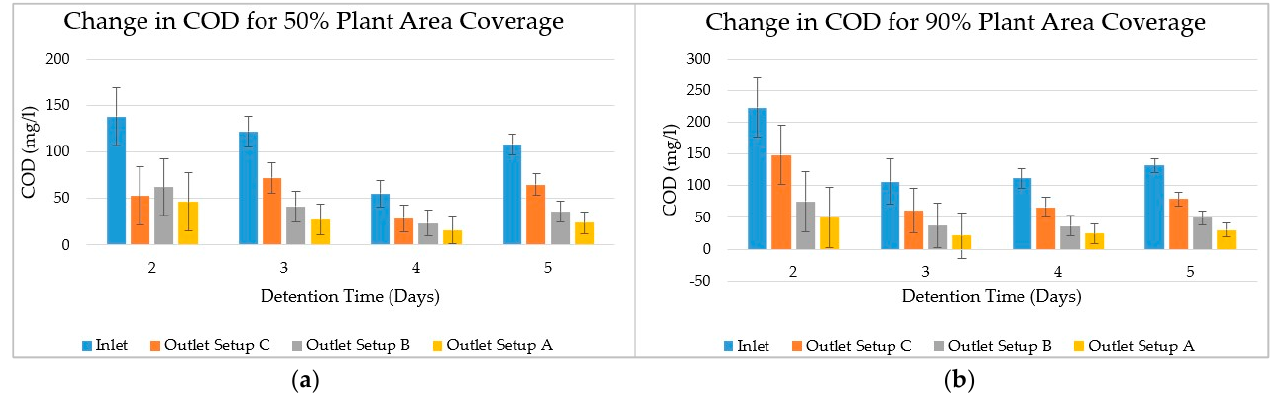
Figure 6. Change in COD with respect to Detention Time: ( a ) Change in COD for 50% plant area coverage; ( b ) Change in COD for 90% plant area coverage .